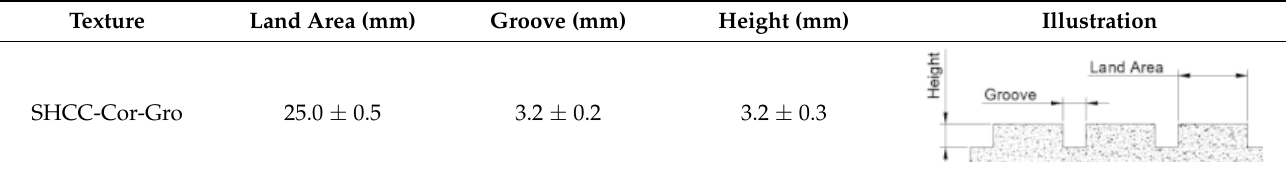
Table 2. Groove dimensions for